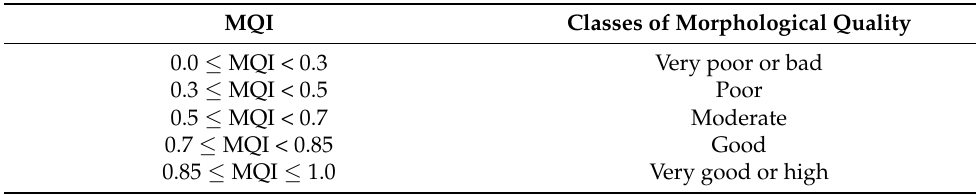
Table 3. MQI values and corresponding